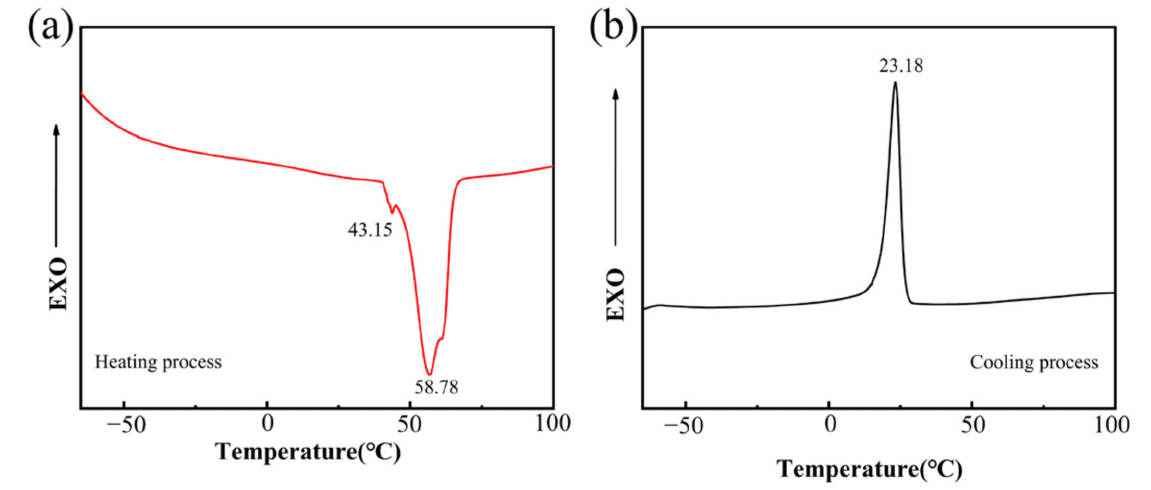
Figure 12. DSC curves ( a ) Heating process and ( b ) Cooling process of the purified